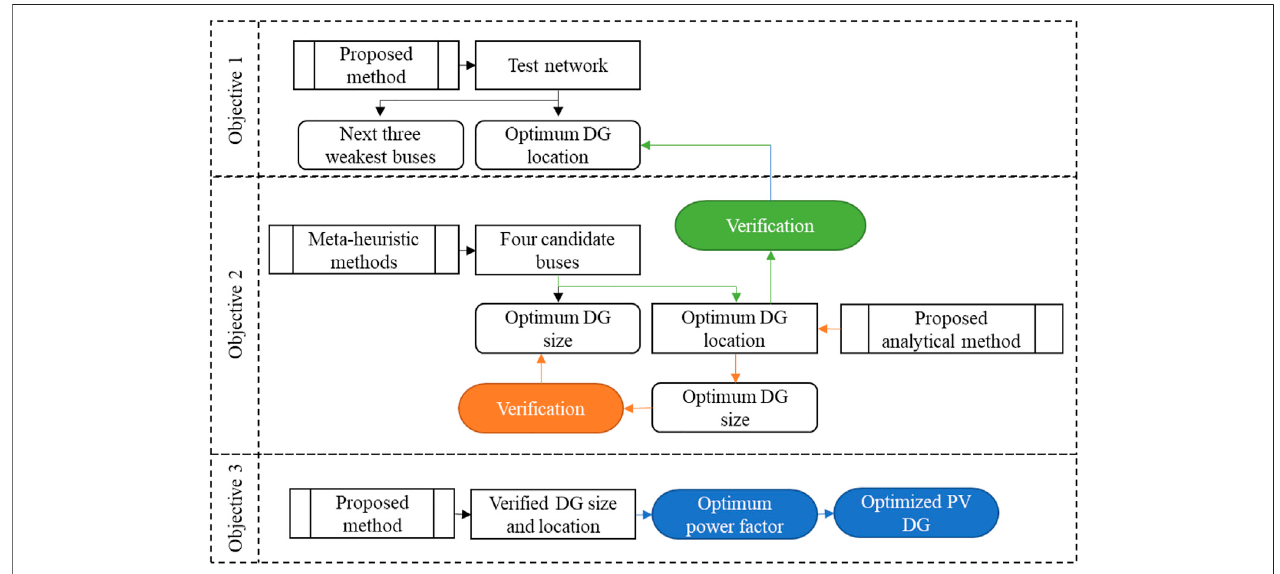
FIGURE 1 | Proposed methodology outline.